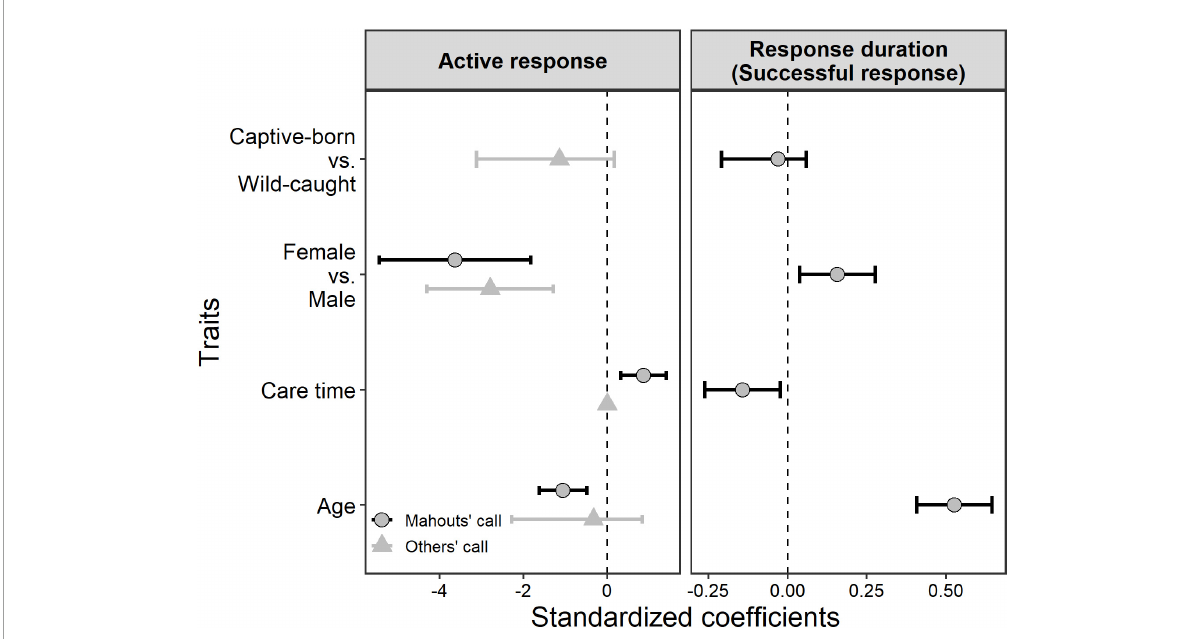
FIGURE4 The individual traits’ influence on the active responses of the elephants when their matching mahouts commanded (right response) or when non-matching mahouts commanded (wrong response), and on the response duration when their matching mahouts commanded (right response). Whiskers represent the 95% confidence interval of the coefficient of each